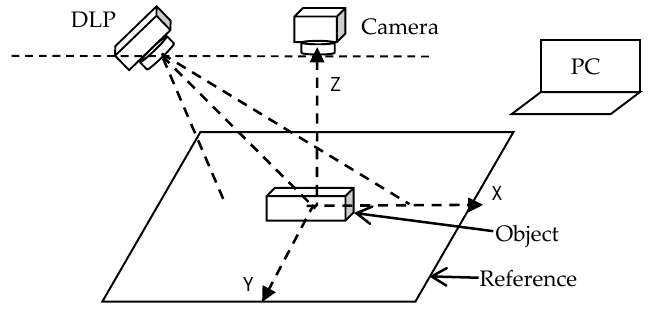
Figure 1. Schematic diagram of measurement principle.